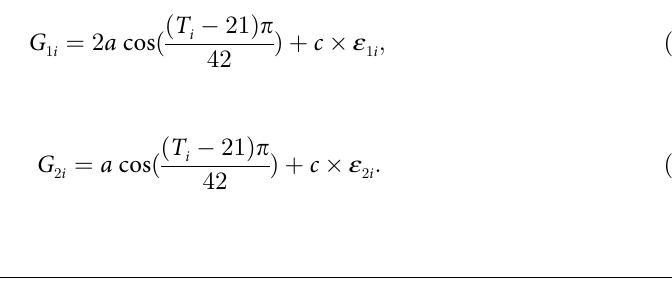
TPR is much higher (63%) than that of Pearson’s correlation (21%), Kendall’s correlation (0%) and dCor (33%), while its FPR (1%) is equivalent to that of Pearson’s and Kendall’s correlation and dCor (0%). Further, Fig 2 shows that when c = 1.0, G and G are nonlinearly correlated, 1 2 -RBF (0.71) is significant, but dCor, Pearson’s and Kendall’s correlation are not (their p-val- K c ues are not < 5 � 10 -4 ; Table 1). The results show that K -RBF outperforms Pearson’s and Kendall’s correlation on the esti- c mation of the nonlinear correlation in data generated with low to medium noise in Case 1. When noise is low, Pearson’s correlation and dCor performs slightly better than K -RBF, K - c c RBF outperforms Pearson’s correlation and dCor when noise is moderate. However, K with c polynomial kernels have high FPRs which may result in overestimation, and Kendall’s correla- tion coefficients are small and insignificant, thus these measures are not suitable for estimation of nonlinear correlation. Case 2.